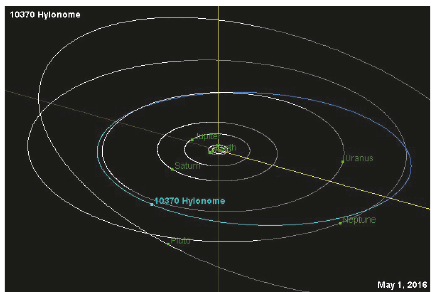
Figure 6: Hylonome’s orbit in relation to the orbits of the planets as referenced on 1 May